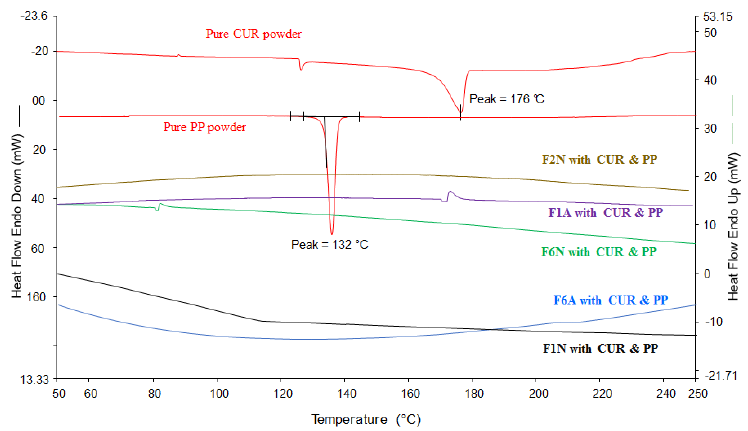
Figure 7. DSC of pure CUR, pure PP and CUR-PP loaded solidified SNEDDS formulations.